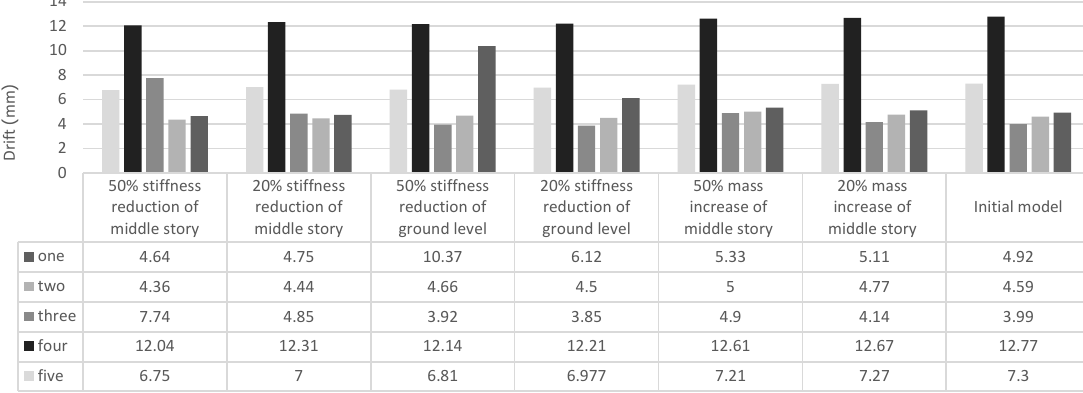
Fig. 11. Drift of 5 story frame.